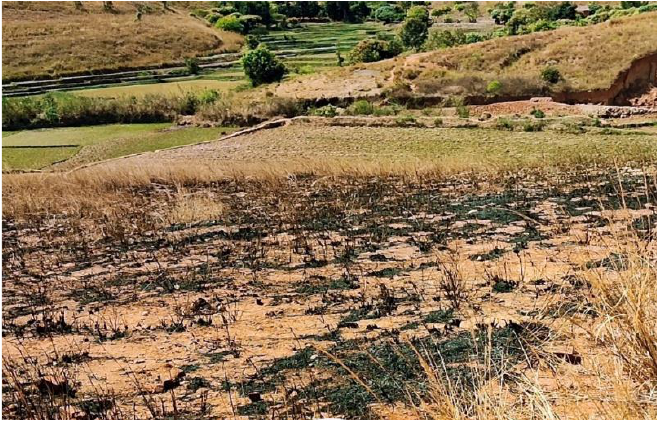
Figure 6. Slash-and-burn agriculture in Bongolava Region, Madagascar. (Photo credit: Zy Misa Harivelo, 20 September 2022)